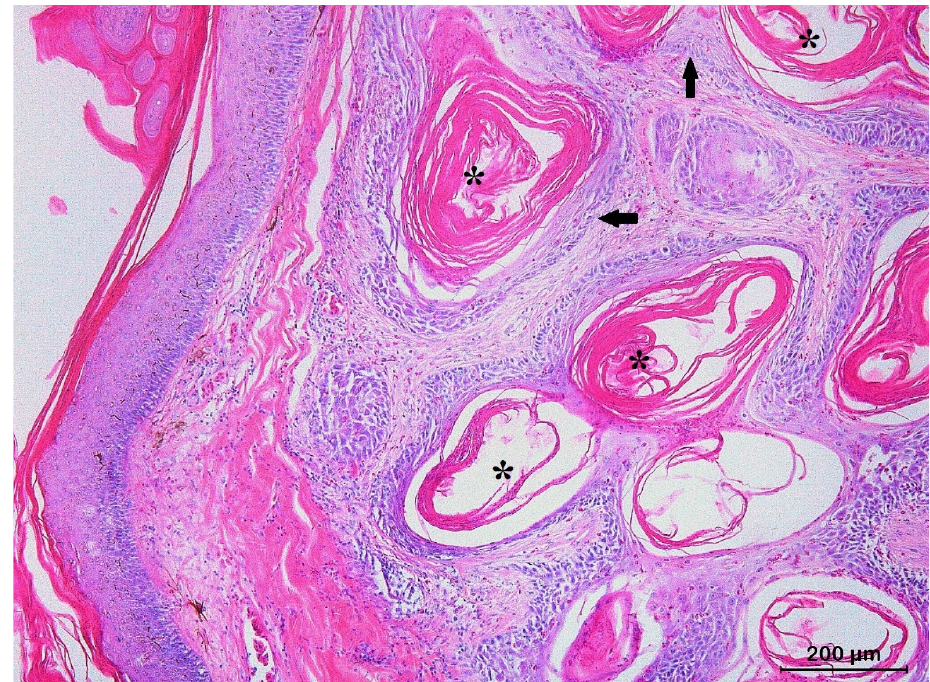
Figure 2. Histological section of a well-differentiated squamous cell carcinomas (SCCs) from the skin of the body wall in a bearded dragon ( Pogona vitticeps ) with tumor cells containing abundant eosinophilic cytoplasm. Synchronous differentiation of peripheral basal-type cells to central squamous epithelial cells (arrows) can be observed, eventually resulting in the formation of keratin pearls (asterisks). Three conventional SCCs were graded as moderately differentiated SCCs based on a low mitotic index and marked nuclear atypia (Figure 3). Keratin pearl formation in moderately differentiated SCCs was a less prominent feature in comparison to well-differentiated SCCs.